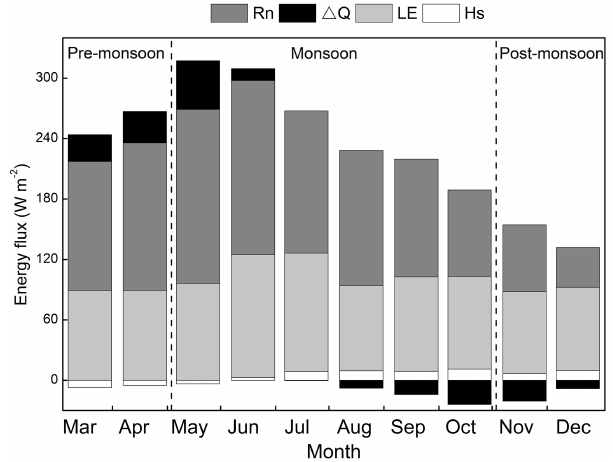
Figure 10. The monthly average energy fluxes (the storage heat flux in the lake, (cid:49)Q ; the net radiation flux, R n ; the latent heat flux, LE; and the sensible heat flux, H s ) during pre-monsoon, monsoon and post-monsoon periods from 2012 to